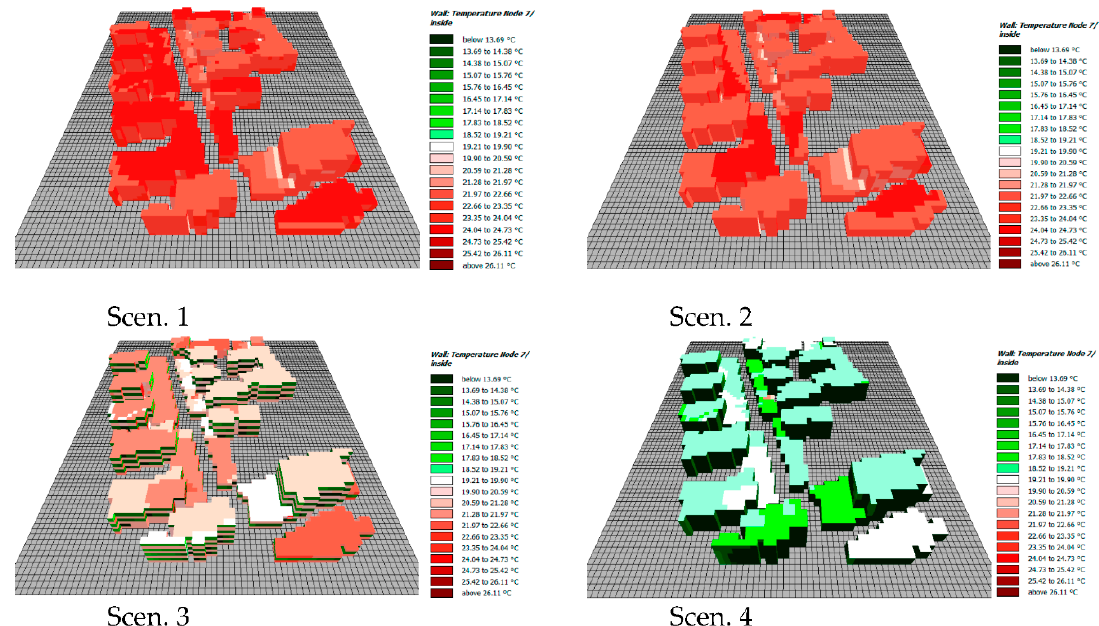
Figure 12. Inside wall surface temperature of the four scenarios at 10 p.m.